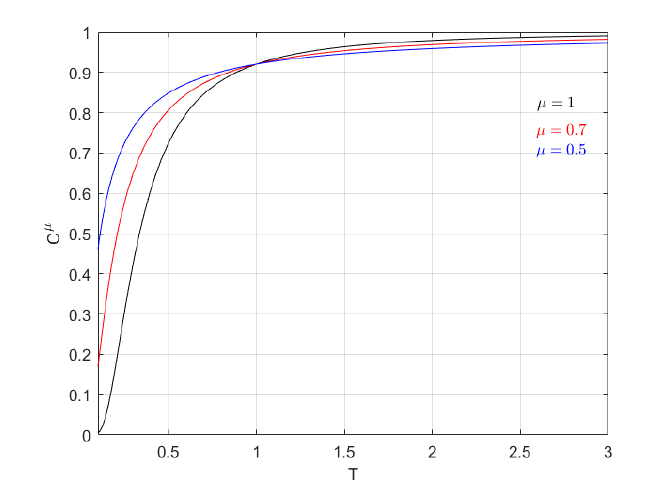
Figure 5. Graph shows Einstein solid model for case of fractal temperature with different